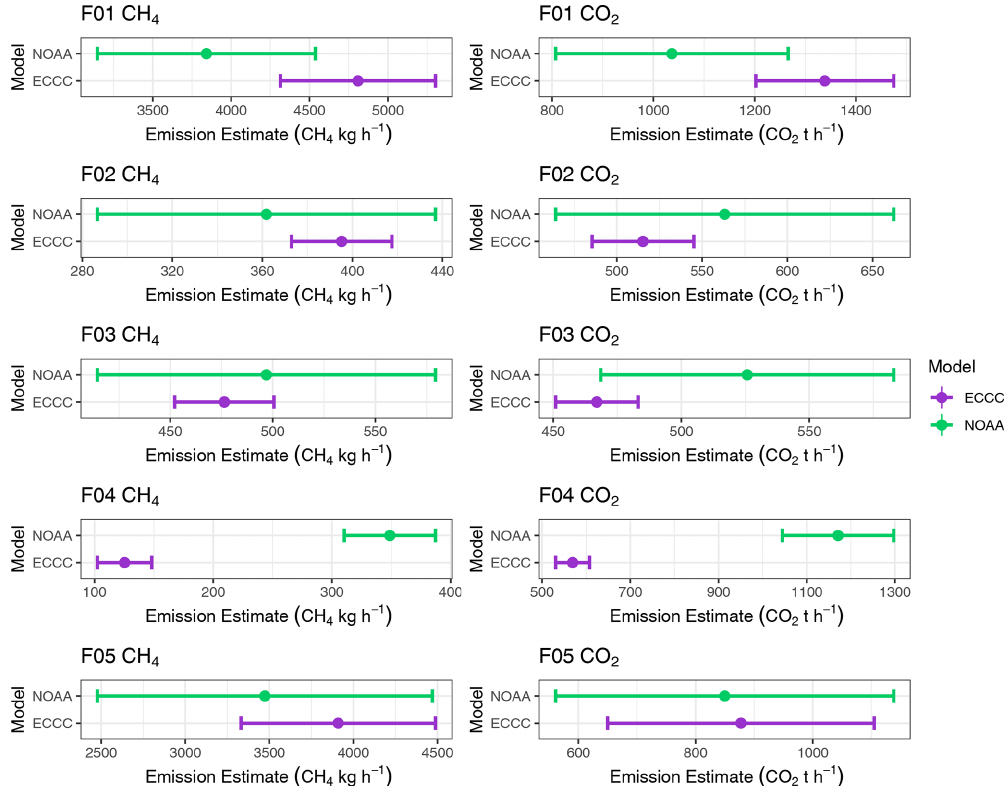
Figure 6. Flight emission estimates for CH 4 (left) and CO 2 (right) derived for each algorithm are plotted as points, along with the range of each estimate, as error bars. TERRA standard estimates are shown in green and SciAv in purple. Samples of F01, F02, F03, and F05 produce estimates that coincide within each method’s error